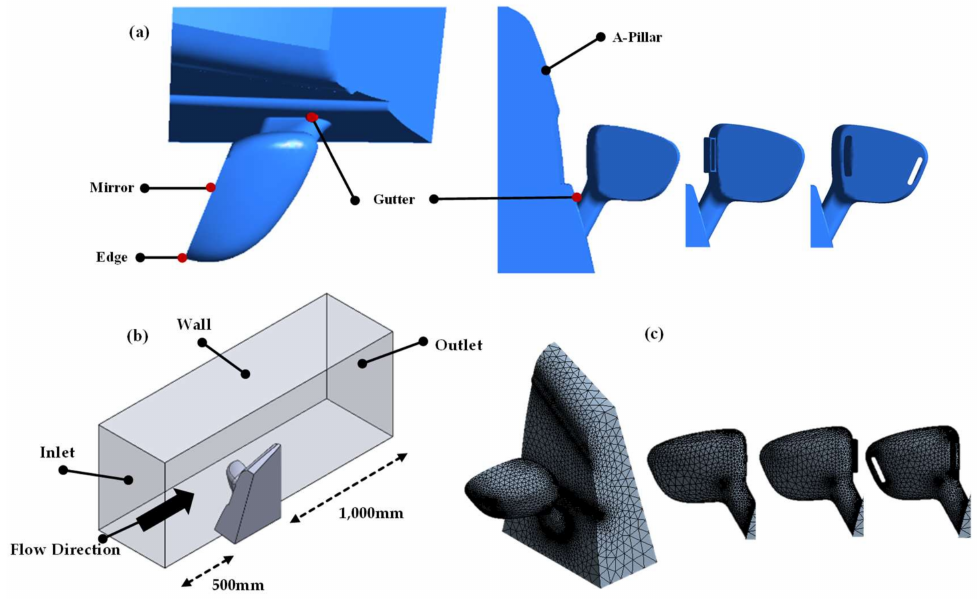
Figure 2. ( a ) The location of gutter, edge, and mirror of the outside rear view mirror (OSRVM) models; ( b ) Computational domain around the side mirror; ( c ) Mesh data of the inner duct OSRVM models. In the simulation, homogeneous velocity was applied at the inlet in the vehicle-driving